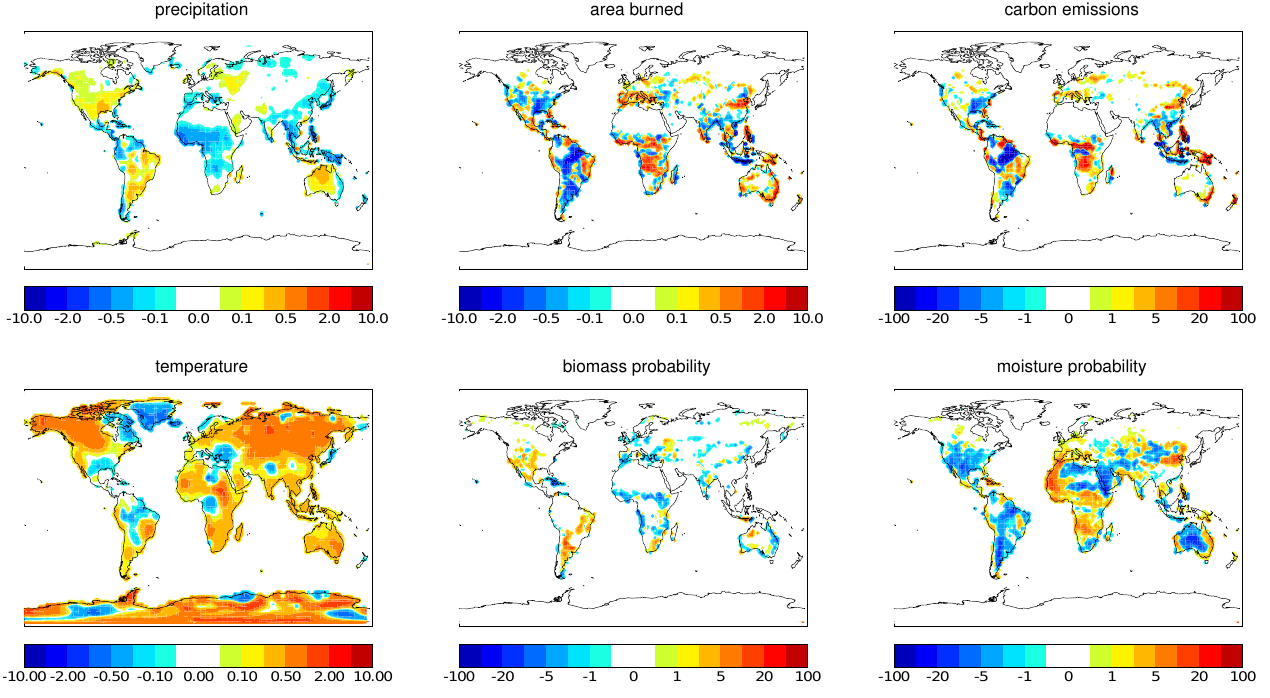
Fig. 7. Difference between simulation AB-FULL and AB-CLIM in annual mean temperature [K], annual mean precipitation [mm/d], annual total area burned [% of grid box], annual mean carbon emissions [gC/m 2 / year] and biomass and moisture probability [ × 100] as defined in Sect. A2 averaged over the period